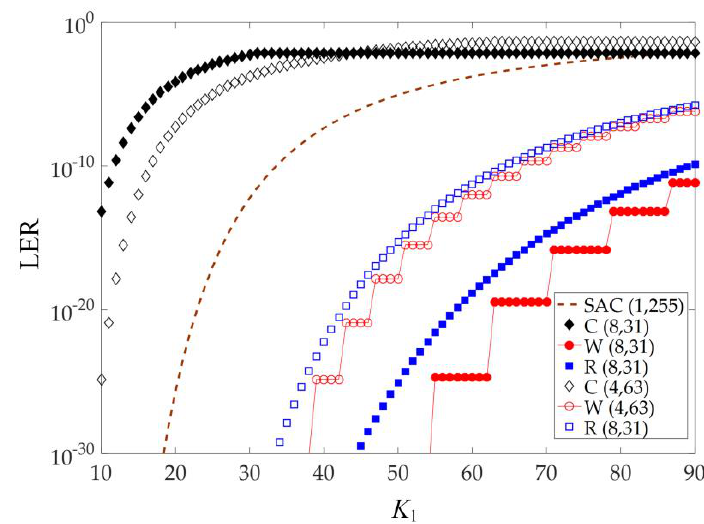
Figure 6. Label-error rate (LER) versus K 1 for the three label stacking scenarios. C: sequential code assignment; W: sequential wavelength assignment; R: random label assignment.